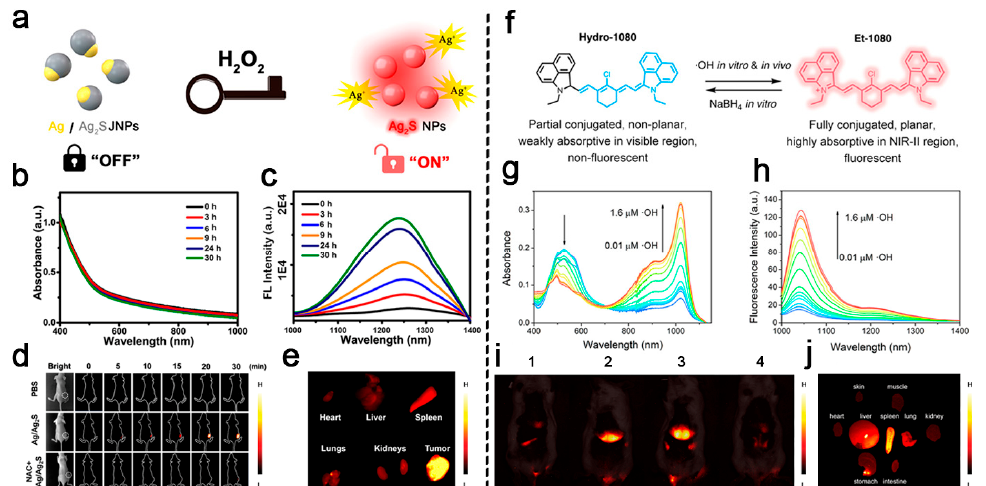
Figure 4. ( a ) Schematic representation of the mechanism of H 2 O 2 -activatable nanoprobe Ag/Ag 2 S JNPs for NIR-II fluorescence imaging in vivo. ( b ) Electronic absorption and ( c ) fluorescence spectra of Ag/Ag 2 S JNPs after treatment with H 2 O 2 at different time points. ( d ) NIR-II fluorescence imaging of tumor-bearing mice at different time points after Ag/Ag 2 S JNP injection in vivo . ( e ) NIR-II fluorescence imaging of tumor and main organs excised from the Ag/Ag 2 S-treated mice group. Reproduced with permission [82]. Copyright 2021, American Chemical Society. ( f ) Chemical structures and mutual conversion processes of Hydro-1080 and Et-1080. ( g ) Electronic absorption and ( h ) fluorescence spectra of Hydro-1080 after reaction with different concentrations of ·OH. ( i ) NIR-IIa fluorescence imaging of mice injected first with different doses of APAP (0, 300, 500, 500 mg/kg) and then with Hydro-1080 (1 mM, 5 mL/kg). In addition, the fourth mouse in the picture was intraperitoneally pre-injected with ABT (100 mg/kg) 24 h before injecting APAP. 1: Hydro-1080; 2: APAP (300 mg/kg) + Hydro-1080; 3: APAP (500 mg/kg) + Hydro-1080; 4: APAP (500 mg/kg) + Hydro-1080 + ABT (100 mg/kg). ( j ) NIR-IIa fluorescence imaging of main organs and tissues of mice injected with APAP (500 mg/kg) and Hydro-1080. Reproduced with permission [88]. Copyright 2019, American Chemical Society.